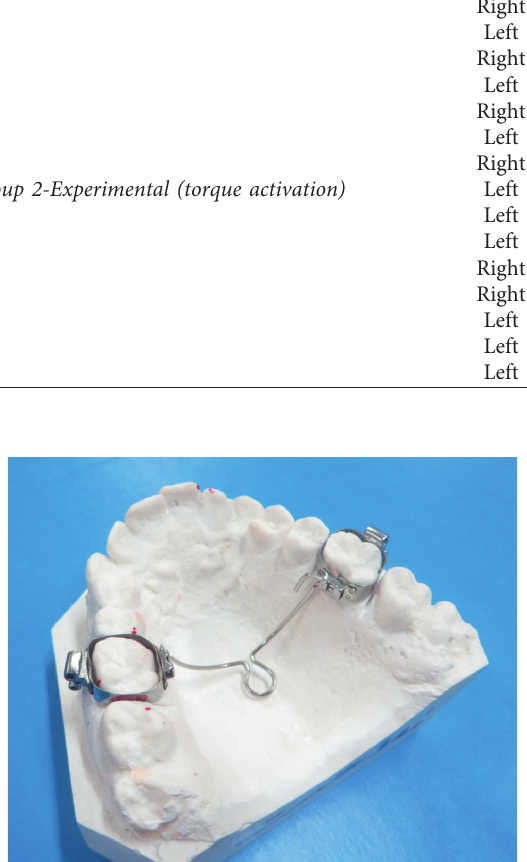
Figure 2: An activated transpalatal arch from the experimental